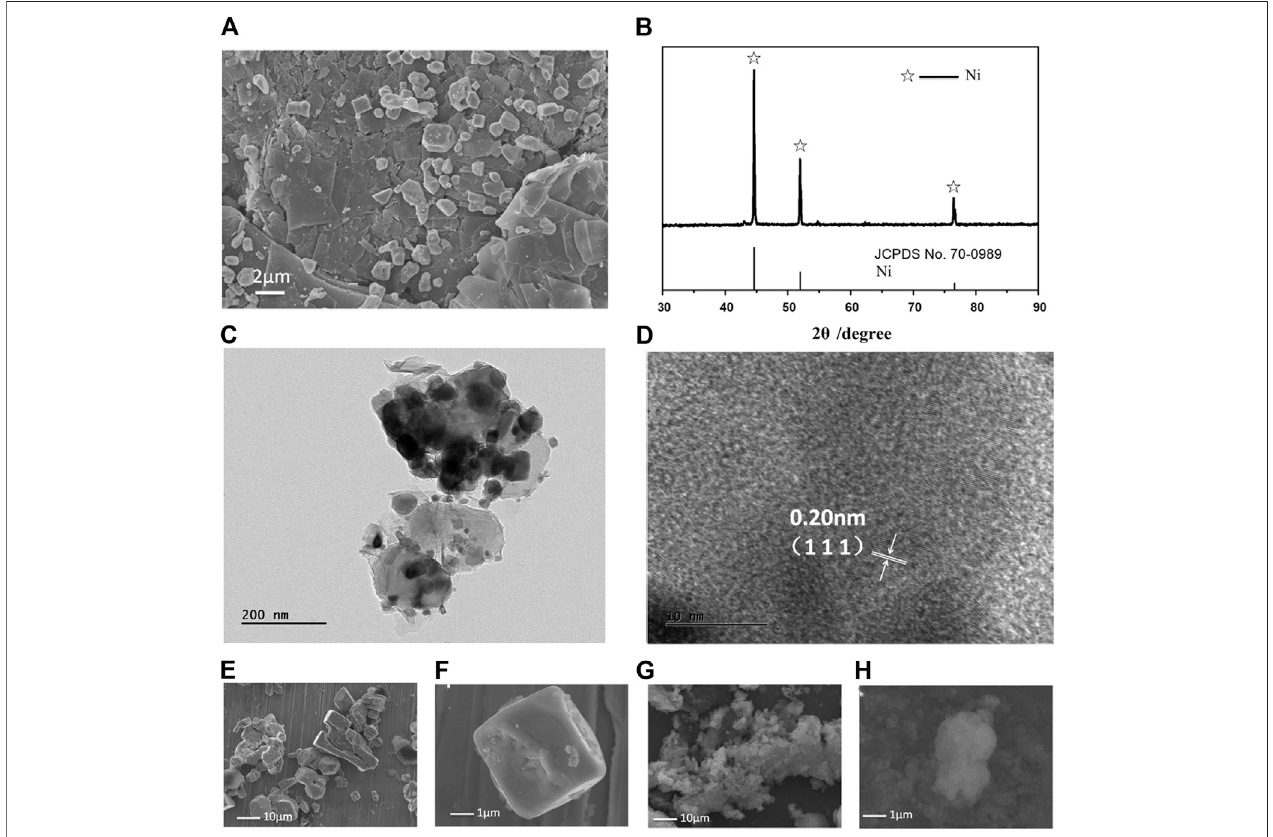
FIGURE 6 | Evolution of product morphologies after the discharge tests. (A) SEM image, (B) XRD pattern, and (C – D) TEM and HRTEM images of the products. SEMimagesoftheproductsareacquired indifferentdischargemodes: (E,F) fastdischargemode(dischargingcurrentdensityof1 A/cm 2 ,50 storeach0 V)and (G,H) no-load mode (maintaining an open-circuit until the battery is